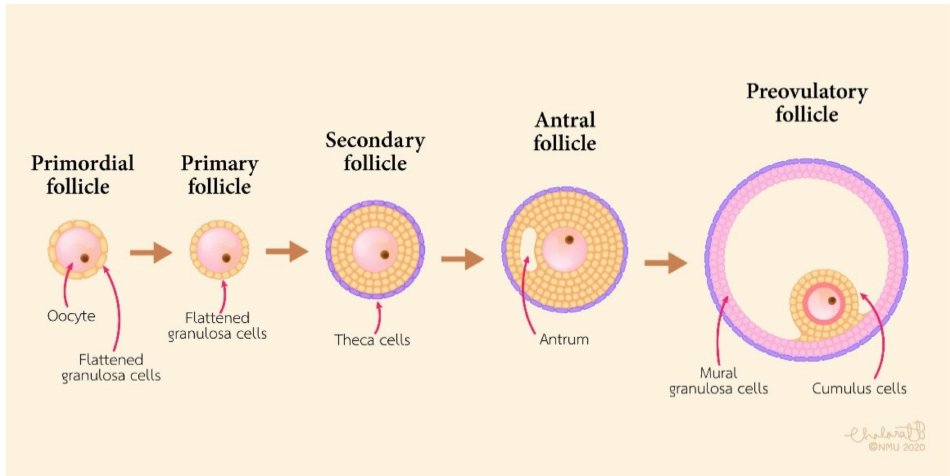
Figure 1. Schematic diagram of follicular